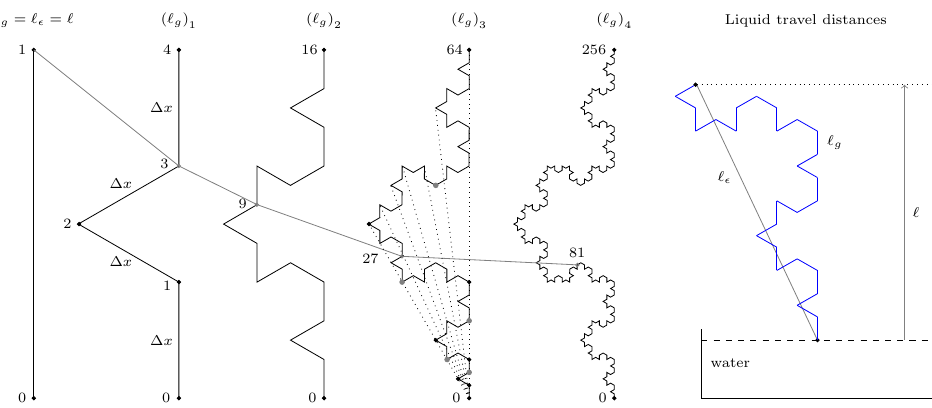
Figure 1. First four iterations of classical von Koch curve [44]. The initiator is equal to Washburn capillary with d H = 1 [16]. The last drawing (blue color) shows the three travel distances of the fluid (for an example of the experimental setup in a vertically straight capillary see [55]).